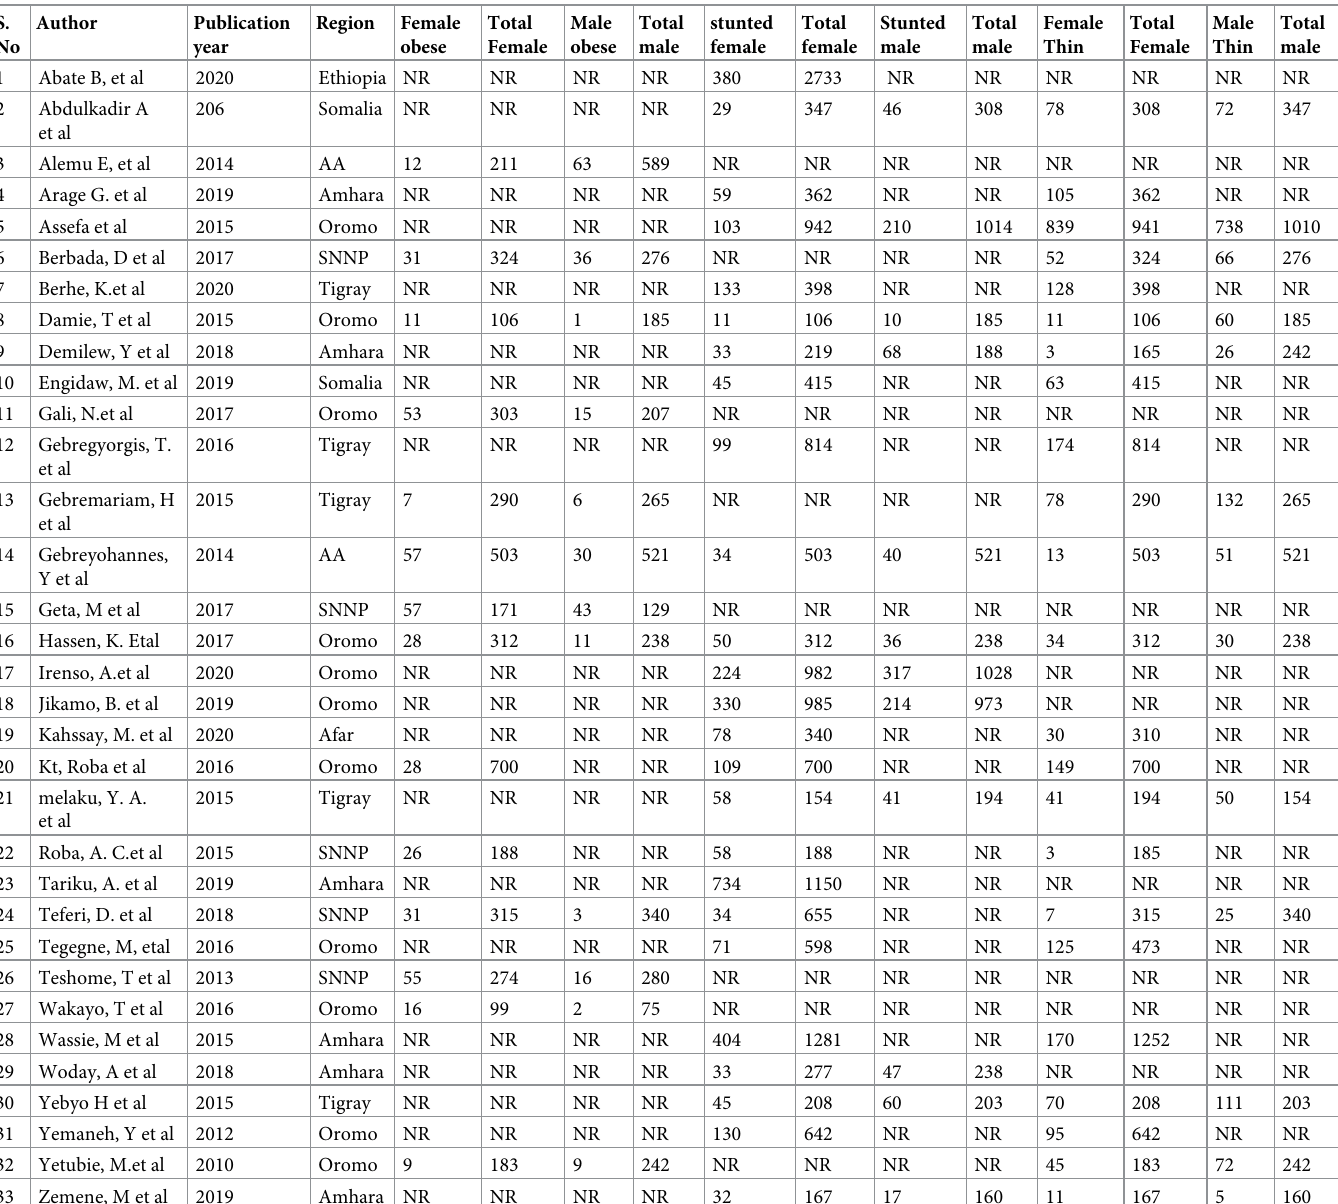
Table 2. Summary of extracted studies subgroup by sex in the analysis of prevalence and associated factors of adolescent’s malnutrition in Ethiopia. S. No